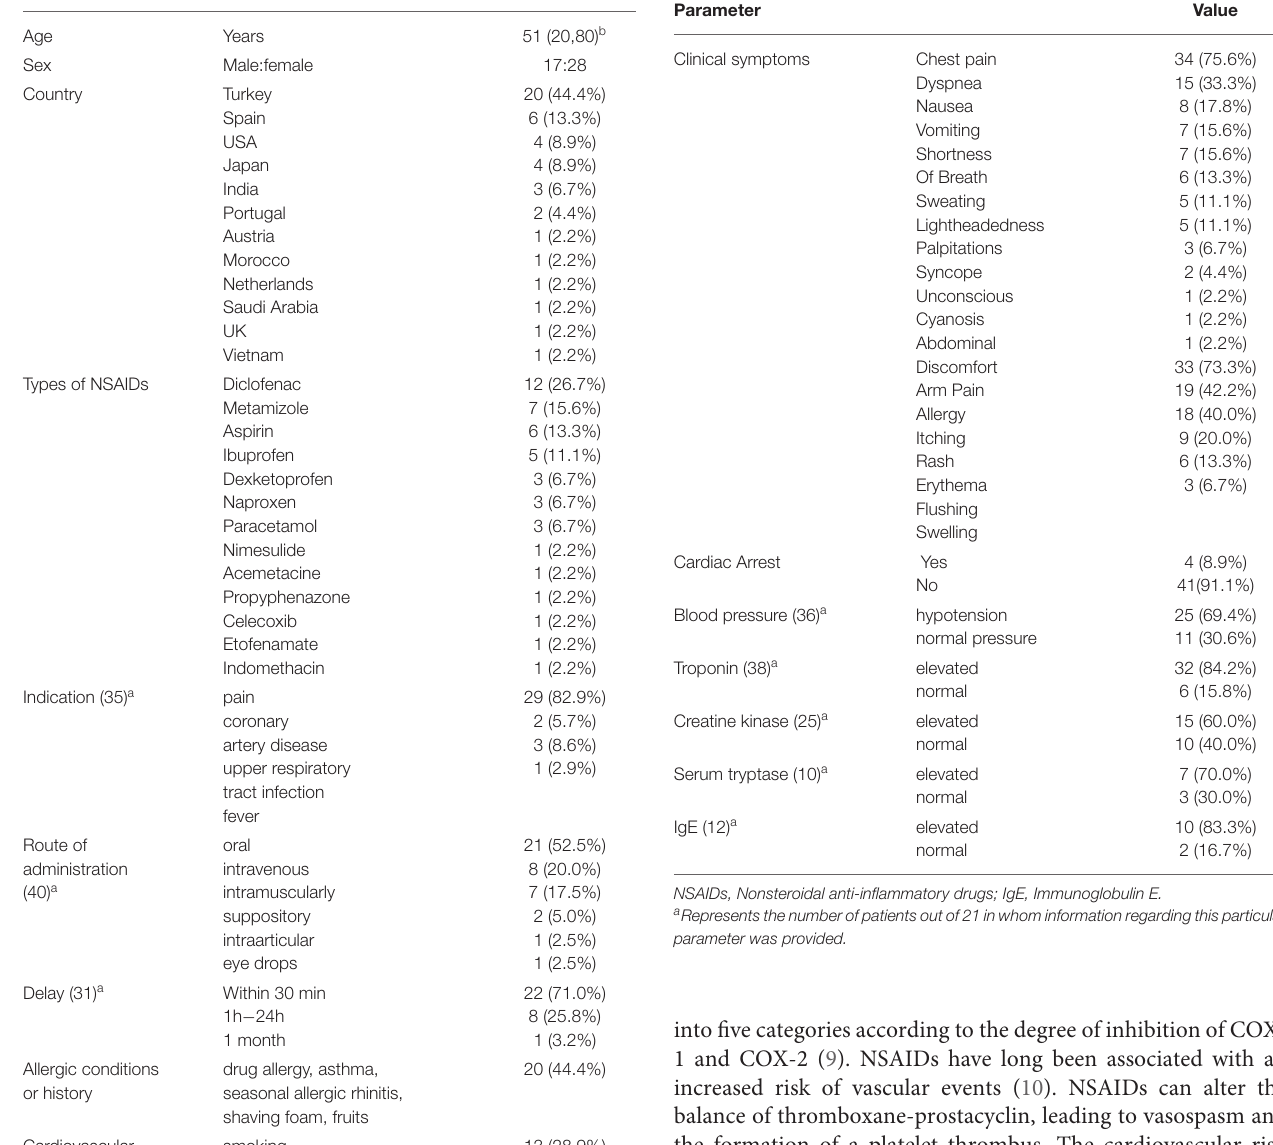
TABLE 1 | Basic information on NSAIDs-induced Kounis syndrome ( n = 45). Parameter